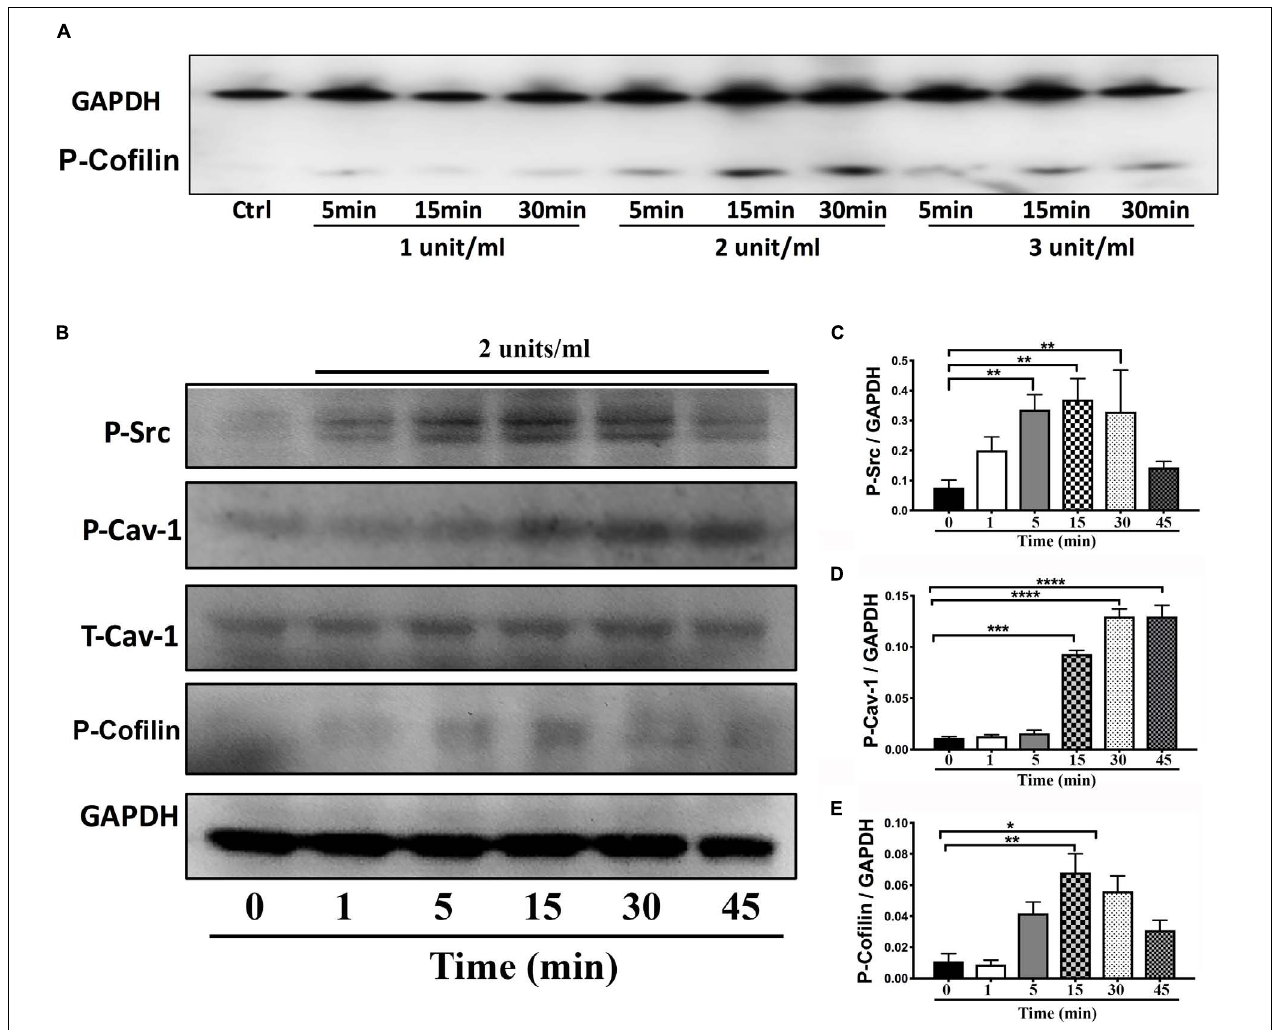
FIGURE 5 | Time-course of P-Cav1 expression with the Rac1/Cdc42 activator in NPCs. (A) NPCs were incubated with three doses of the Rac1/Cdc42 activator (1–3 units/ml) and assayed for P-cofilin at three time points (5, 15, and 30 min) using Western blot. (B) NPCs were incubated with 2 units/ml of the activator followed by Western blot for P-Cav-1, T-Cav-1, P-Src, and P-cofilin at 1, 5, 15, 30, and 45 min. Quantitation is shown for P-Cav-1 (C) , P-Src (D) , and P-Cofilin (E) . Data are expressed as mean ± S.E ( n = 3, ∗ p < 0.05, ∗∗ p < 0.01, ∗∗∗ p < 0.001, ∗∗∗∗ p < 0.0001, One-way